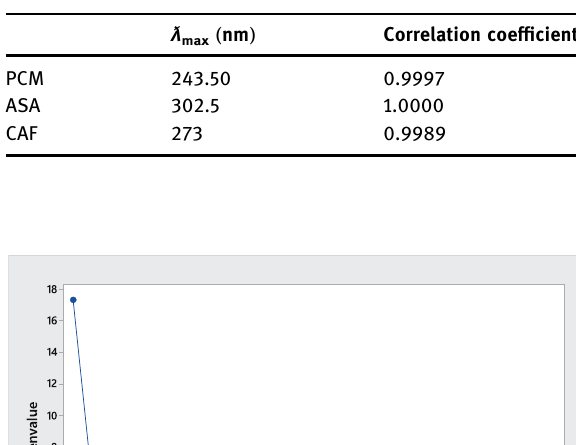
Table 2: Spectroscopic properties of drugs